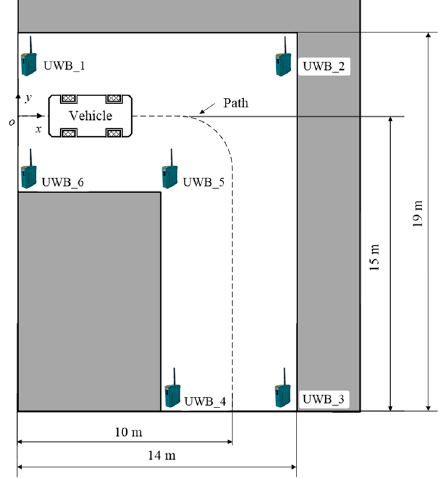
Figure 8. Site of quarter turn path.